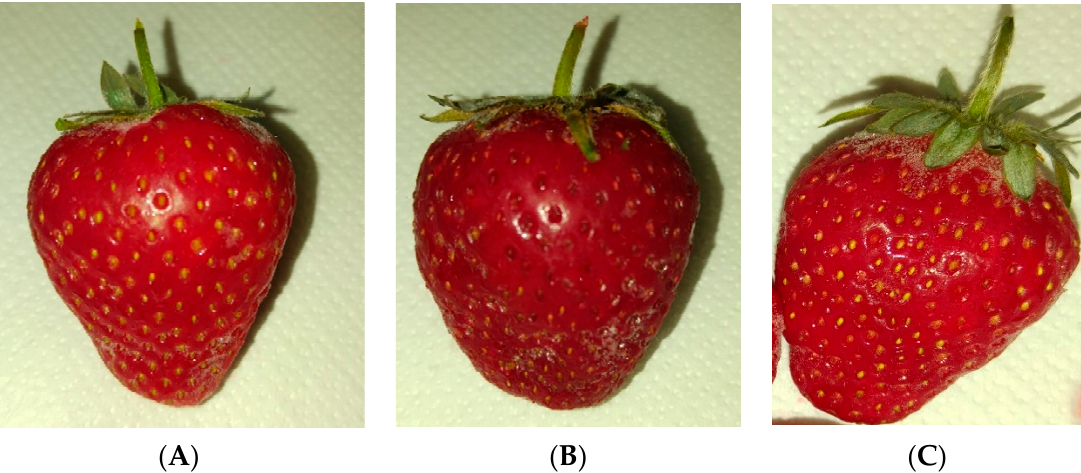
Figure 1. Control strawberry ( A ); H. halys ‐ infested strawberry ( B ); and indirectly H. halys ‐ infested strawberry ( C ).